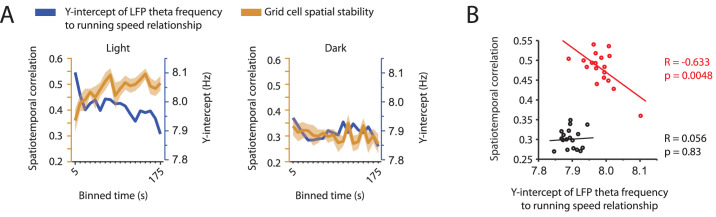
Changes in grid cell spatial stability as a function of time do not align with changes in the y-intercept of the local field potential theta frequency vs. running speed relationship.(A) Overlay of data shown in Figure 8D and 1J comparing the time course of changes in the y-intercept of the theta frequency vs. running speed relationship (blue colors) and the spatial stability of grid cell firing measured by the spatiotemporal correlation (ocher colors). Left and right panels show data on first three minutes in the light and dark conditions, respectively. (B) Scatter plot of time-binned data shown in A (each data point shows the mean values of y-intercept and grid cell stability at each time point in A). Black line shows the linear regression of data in the dark condition; n = 18 time points, R = 0.056, p=0.83. Red line shows the linear regression in the light condition; n = 18 time points, R = –0.633, p=0.0048.